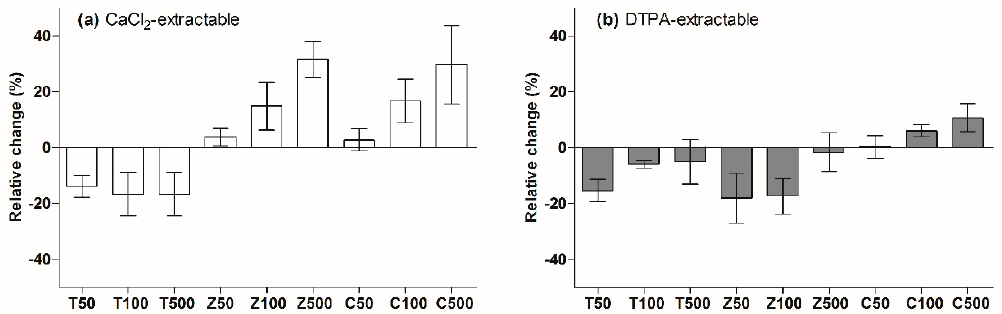
Figure 5. Relative change in soil Cd bioavailability after the addition of nanoparticles.